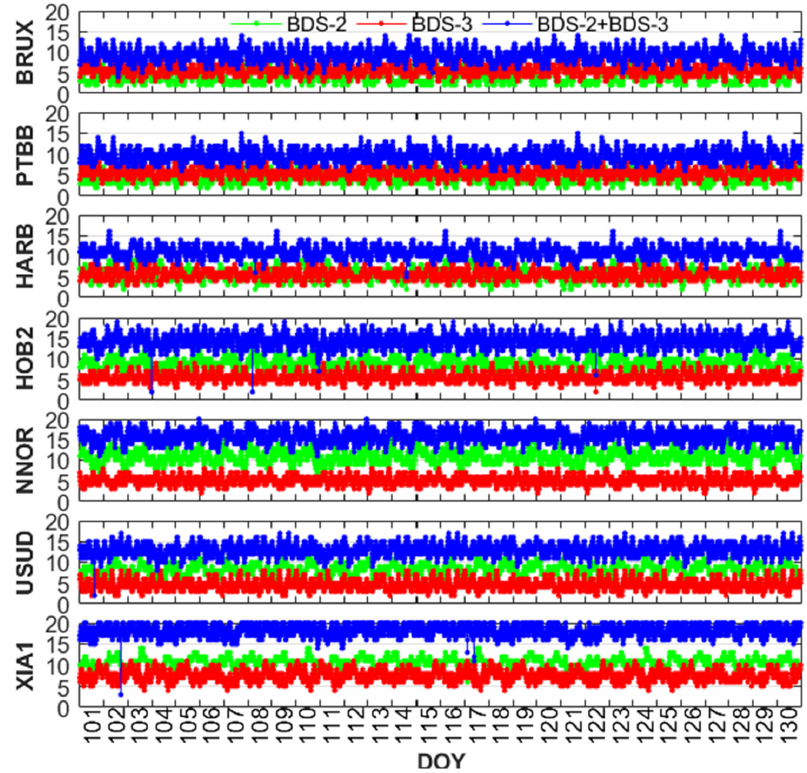
Figure 3. Number of visible satellites for BDS-2-only, BDS-3-only, and BDS (BDS-2/BDS-3). The BDS PPP processing strategies are illustrated in Table 3. For BDS precise time and frequency transfer, the BDS precise orbit and clock offsets products provided by GFZ and WHU are used. The BDS B1I and B3I signals are used to perform BDS-2 and BDS-3 POD and PCE, the coordinate frame of precise products is IGS14[33], the time system of precise products is GPS time (GPST), and the sampling interval of satellite orbit and clock products for WHU and GFZ are 15 min, 30 s and 5 min, 30 s, respectively [25,26,28,29]. The satellite differential code bias (DCB) are provided by Chinese Academy of Sciences (CAS) [34]. The antenna file data (igs14_2076_plus.atx) provided by IGS MGEX [33,35] are utilized to correct the phase center offset of BDS satellite and receiver antenna, which is consistent with WHU and GFZ[25,26,28,29]. About the tropospheric delay, the combina- tion of modified Hopfield model and Global Pressure and Temperature 3 (GPT3) is used to correct the dry tropospheric delay, and the mapping functions of both dry and wet parts are obtained by Vienna mapping functions 3 (VMF3) according to the elevation an- gle of each satellite [36]. Previous reports indicated that there are systematic errors related to elevation angle exist in the BDS-2 triple frequencies signals [37,38]. To avoid the influ- ence of this errors on ISB, we have corrected these errors. In the Kalman filtering, the sta- tion coordinates and ambiguities are estimated as constants, the receiver clock is estimated as white noises, and the tropospheric ZWD is estimated as a random walk process. For ISB estimation, the ISB stochastic models, i.e., ISB NO , ISB CV , ISB RW , and ISB WN are per- formed. 0.4 m and 0.004 m are set as priori precision for BDS code and phase observations [39], respectively. Considering that the orbit and clock accuracy of BDS GEO satellite are relatively poor, we set a factor of 10 to down-weight their observations [14,24,40].